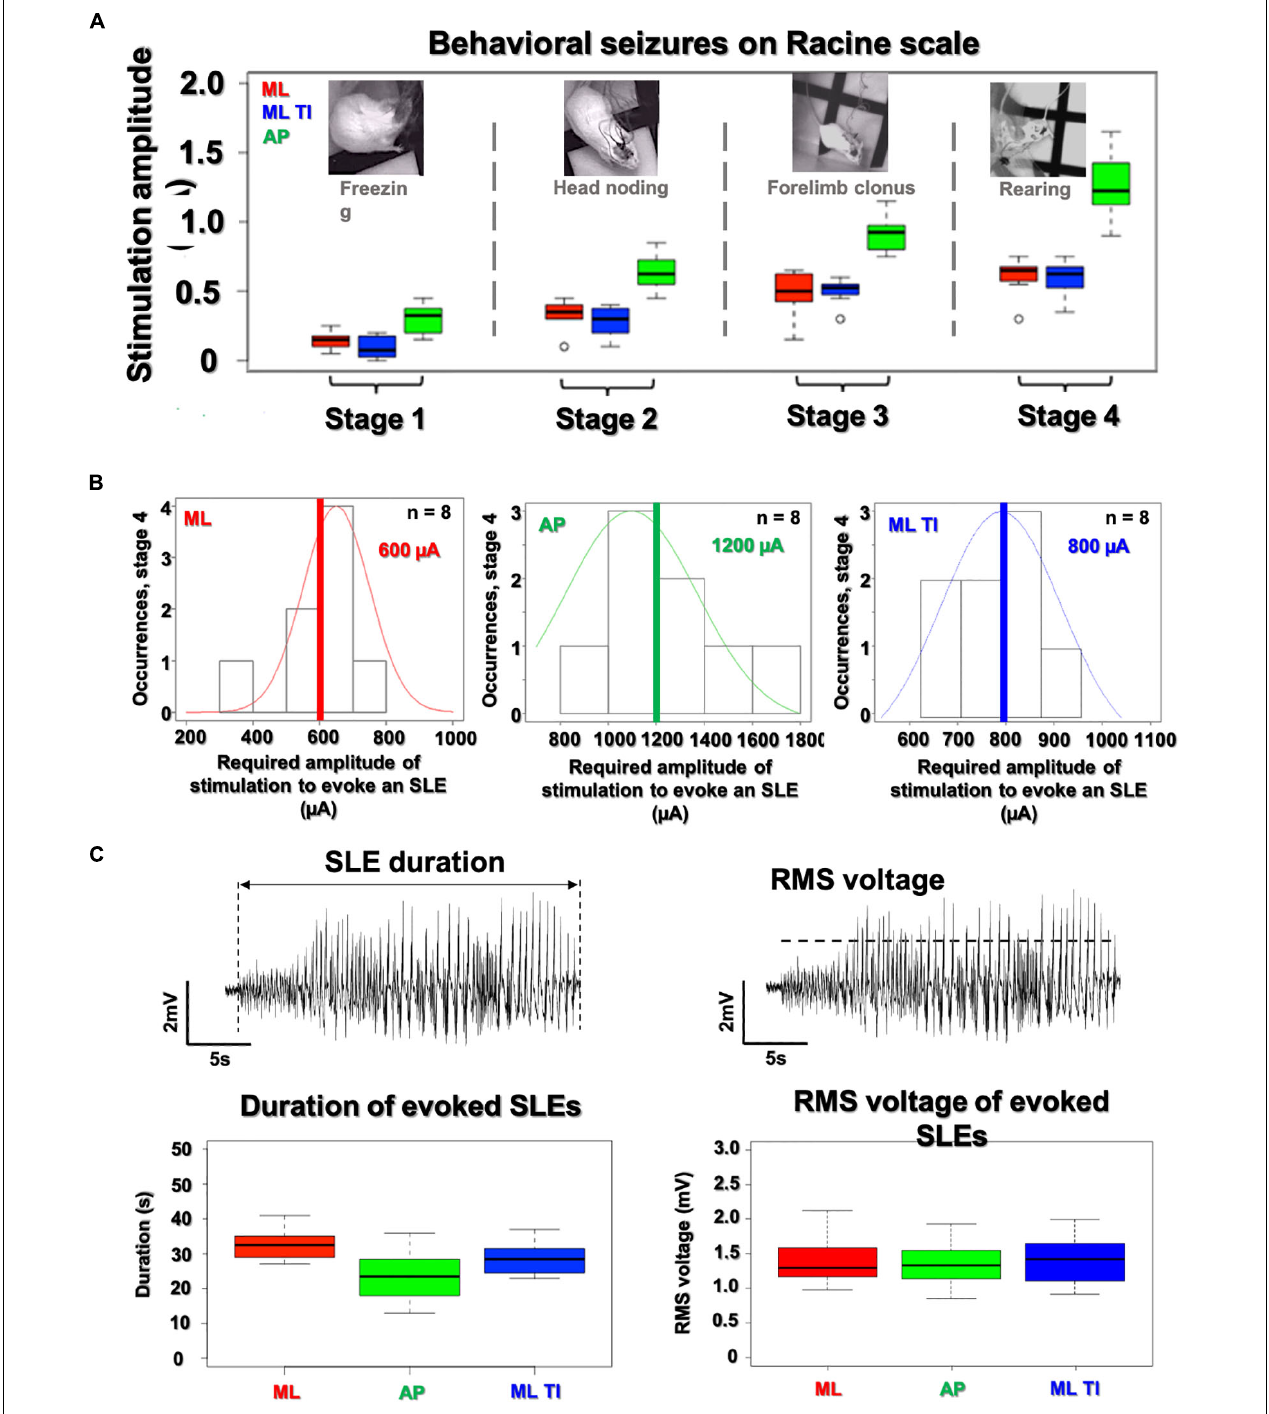
FIGURE 6 | Analysis of SLE characteristics (amplitude, duration, and severity) in the hippocampus. All SLEs detected have been characterize in amplitude, duration and severity. (A) No differences are observed between ML-implantable (red) and ML-ot-TI (blue) ( p -value > 5%) for evoked behavioral changes on the Racine scale as a function of stimulation amplitude. AP requires increased stimulation amplitude for each stage. Black line of box plots represents the median. (B) Distribution of SLEs for the 4th stage of the Racine scale, the normalized distribution of thresholds do not show any differences between ML-implantable and ML-ot-TI ( p -value > 5%), but the AP-implantable stimulation (green) needs double the current to evoke Stage 4 behavior and electrophysiological SLEs. Red, Green, and Blue lines represent the mean. (C) The recorded amplitude and duration of evoked electrophysiological SLEs for Racine Stage 4: ML-implantable (red), AP-implantable (green), and ML-ot-TI (blue) show no differences ( p -value > 5%). Every group of mice in each panels (A–C) are n = 8.